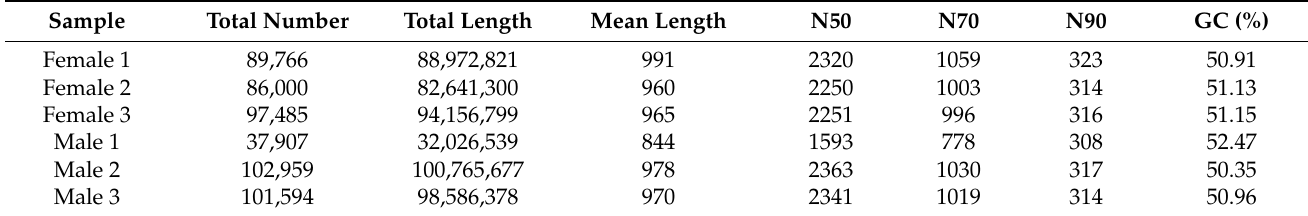
Table 3. Transcriptome assemblies.